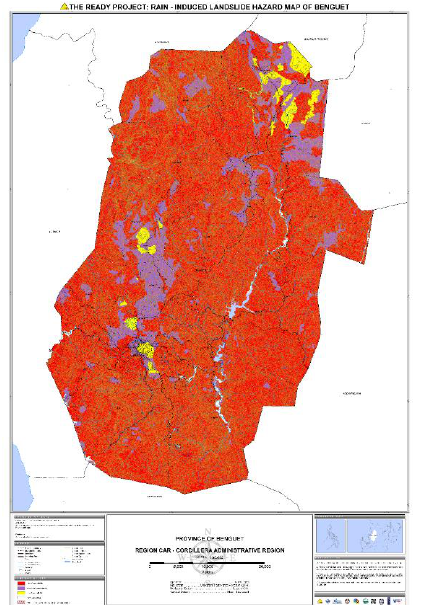
Figure 7. Rain-induced landslide susceptibility map from